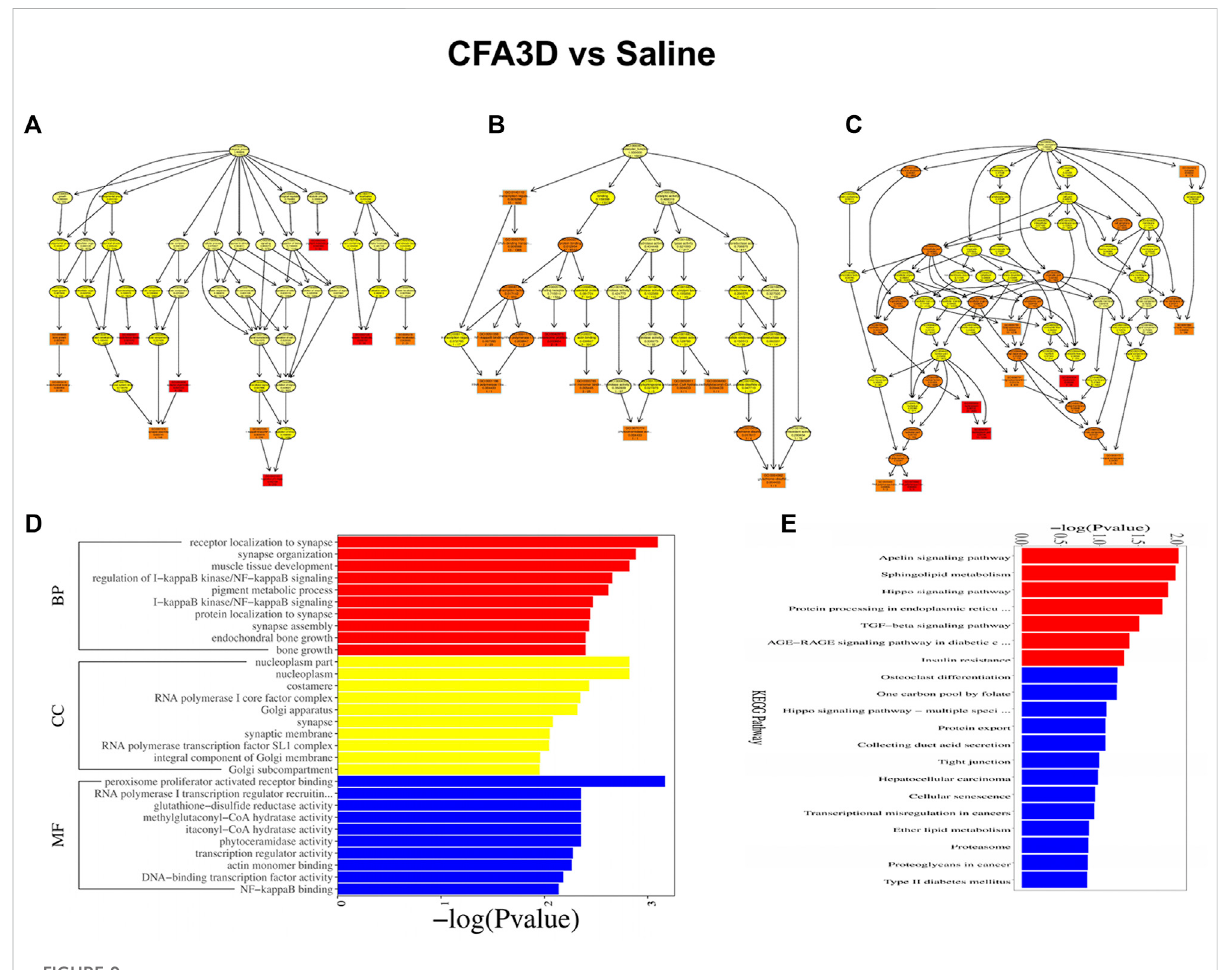
Table S4. Among these DEGs, Bdnf increased 2 times on CFA3D and 3.8 times on CFA6D, irak1 increased 6.2 times on CFA3D and 6.2 times on CFA6D, nf1 increased 3.4 times on CFA3D